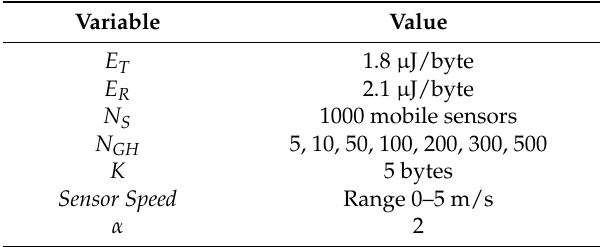
Table 3. Parameter values used in the